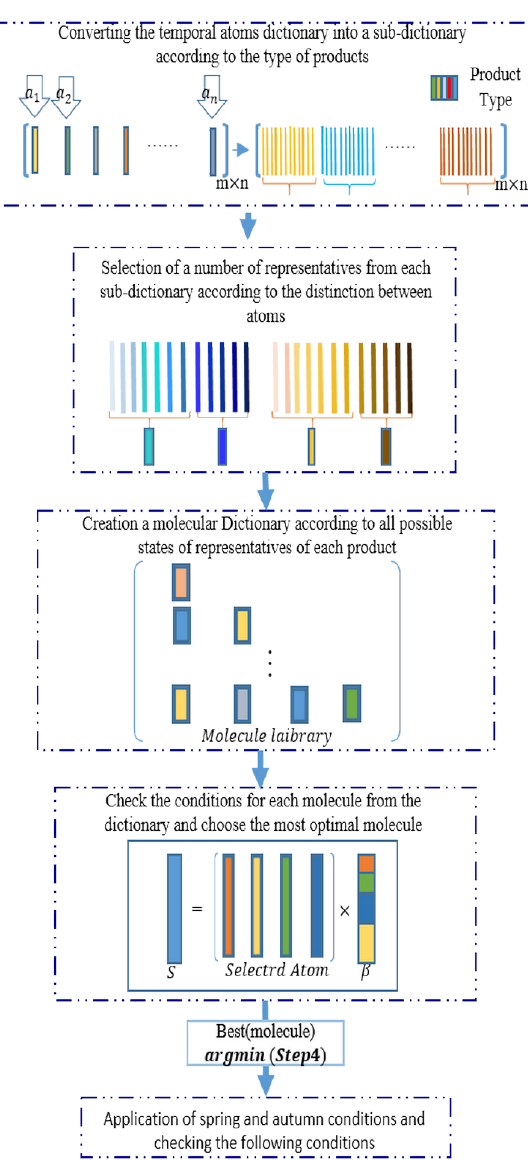
Figure (2). Flowchart of the proposed method based on the use of molecules in sparse decomposition of VI time series Step 1 - the atoms of the dictionary are separated into subgroups related to each agricultural product. The sub- dictionary of each product might also be separated into several distinct categories due to their interclass scattering caused by diversity in the type of seed, irrigation, climate, and agricultural